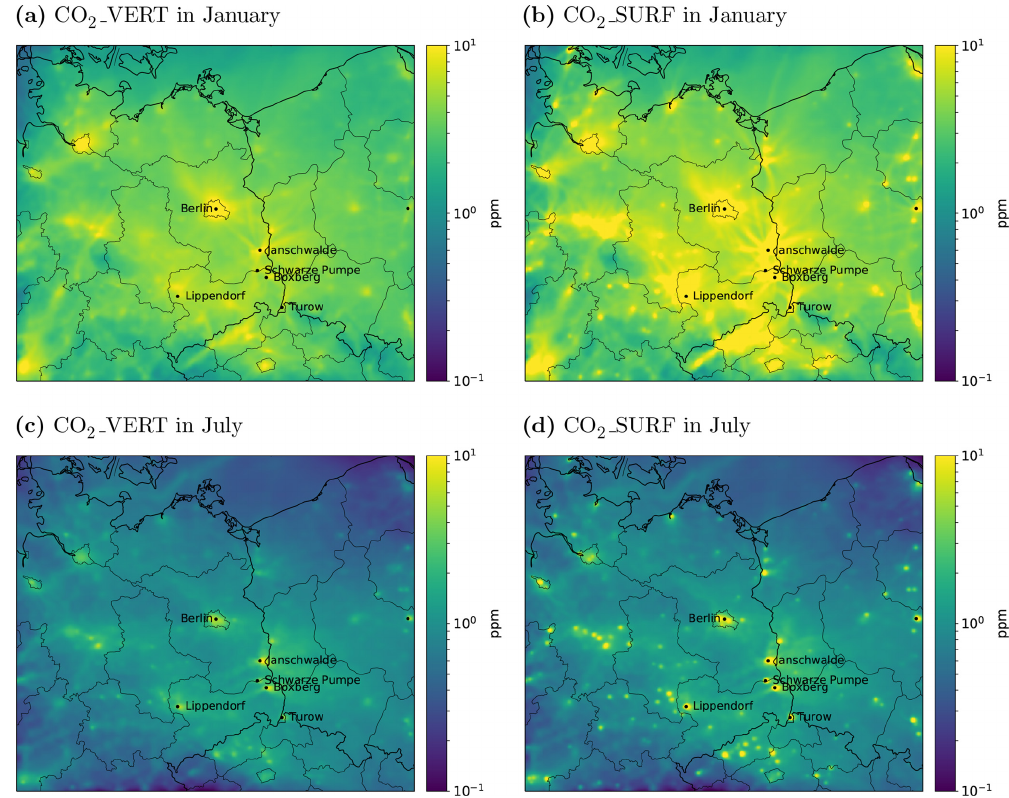
Figure 6. Mean afternoon (14:00–16:00LT) near-surface CO 2 in (a, b) January and (c, d) July contributed by all anthropogenic sources in the domain. (a, c) Tracer CO2_VERT released according to realistic vertical profiles. (b, d) Tracer CO2_SURF released only at the surface.